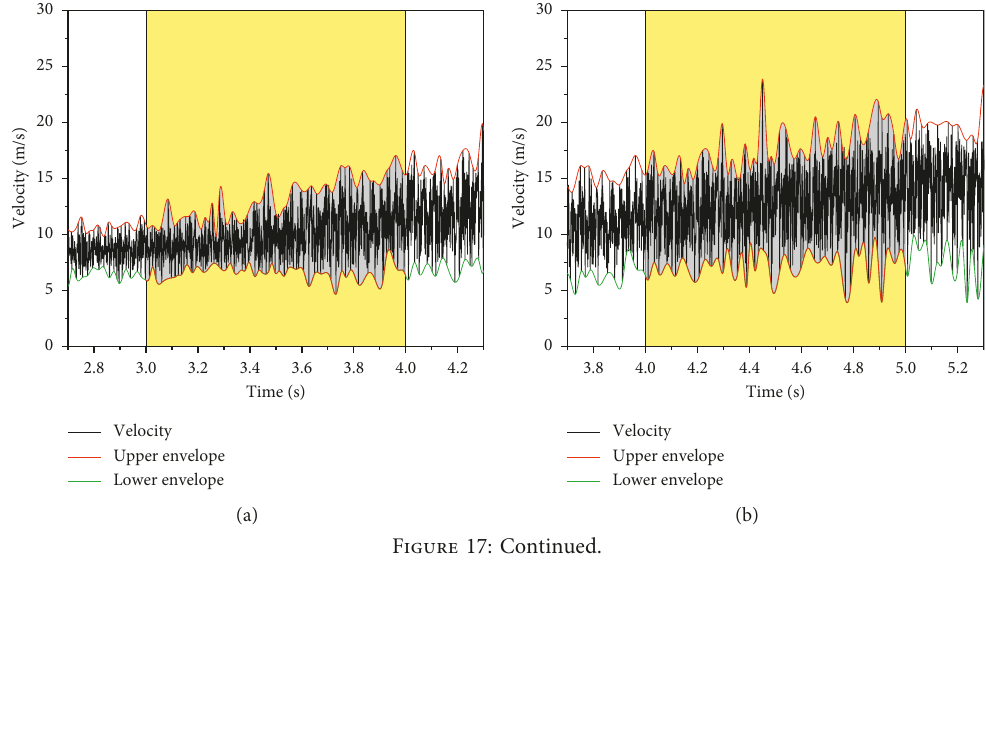
Figure 16: Curve for relationship between pressure fluctuation and time at different flow rates. (a) Found 65 peaks, Q 76 peaks, Q 5.4m 3 /h. (c) Found 73 peaks, Q (cid:31) peaks, Q 9.0m 3 (cid:31)